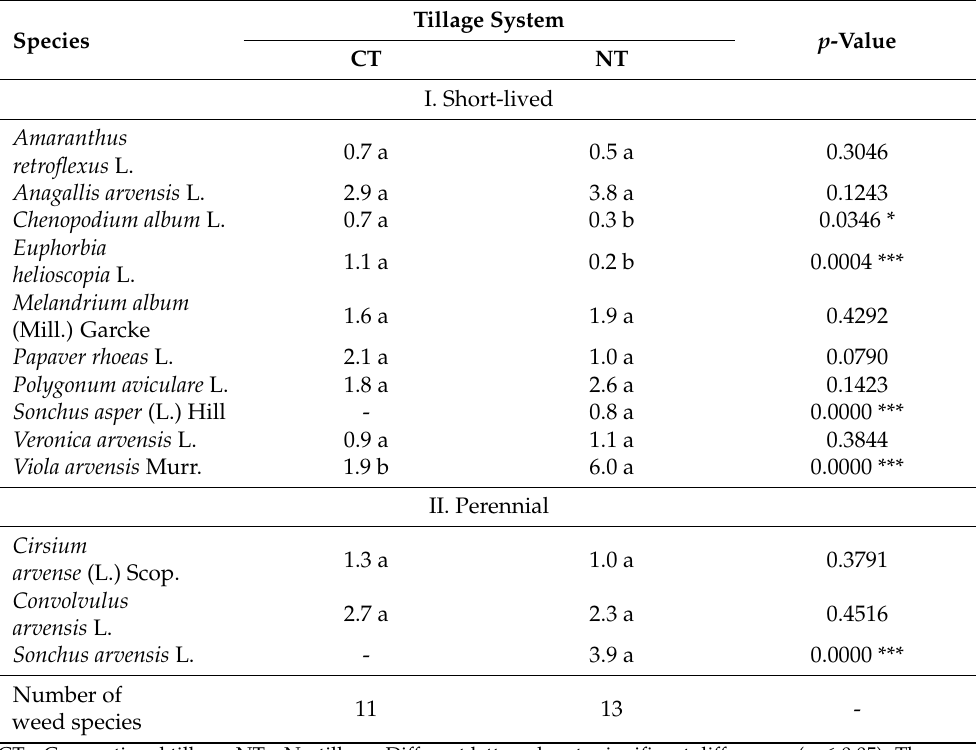
Table 8. Species composition of weeds per 1m 2 in winter oilseed rape crop depending on the tillage system (mean for